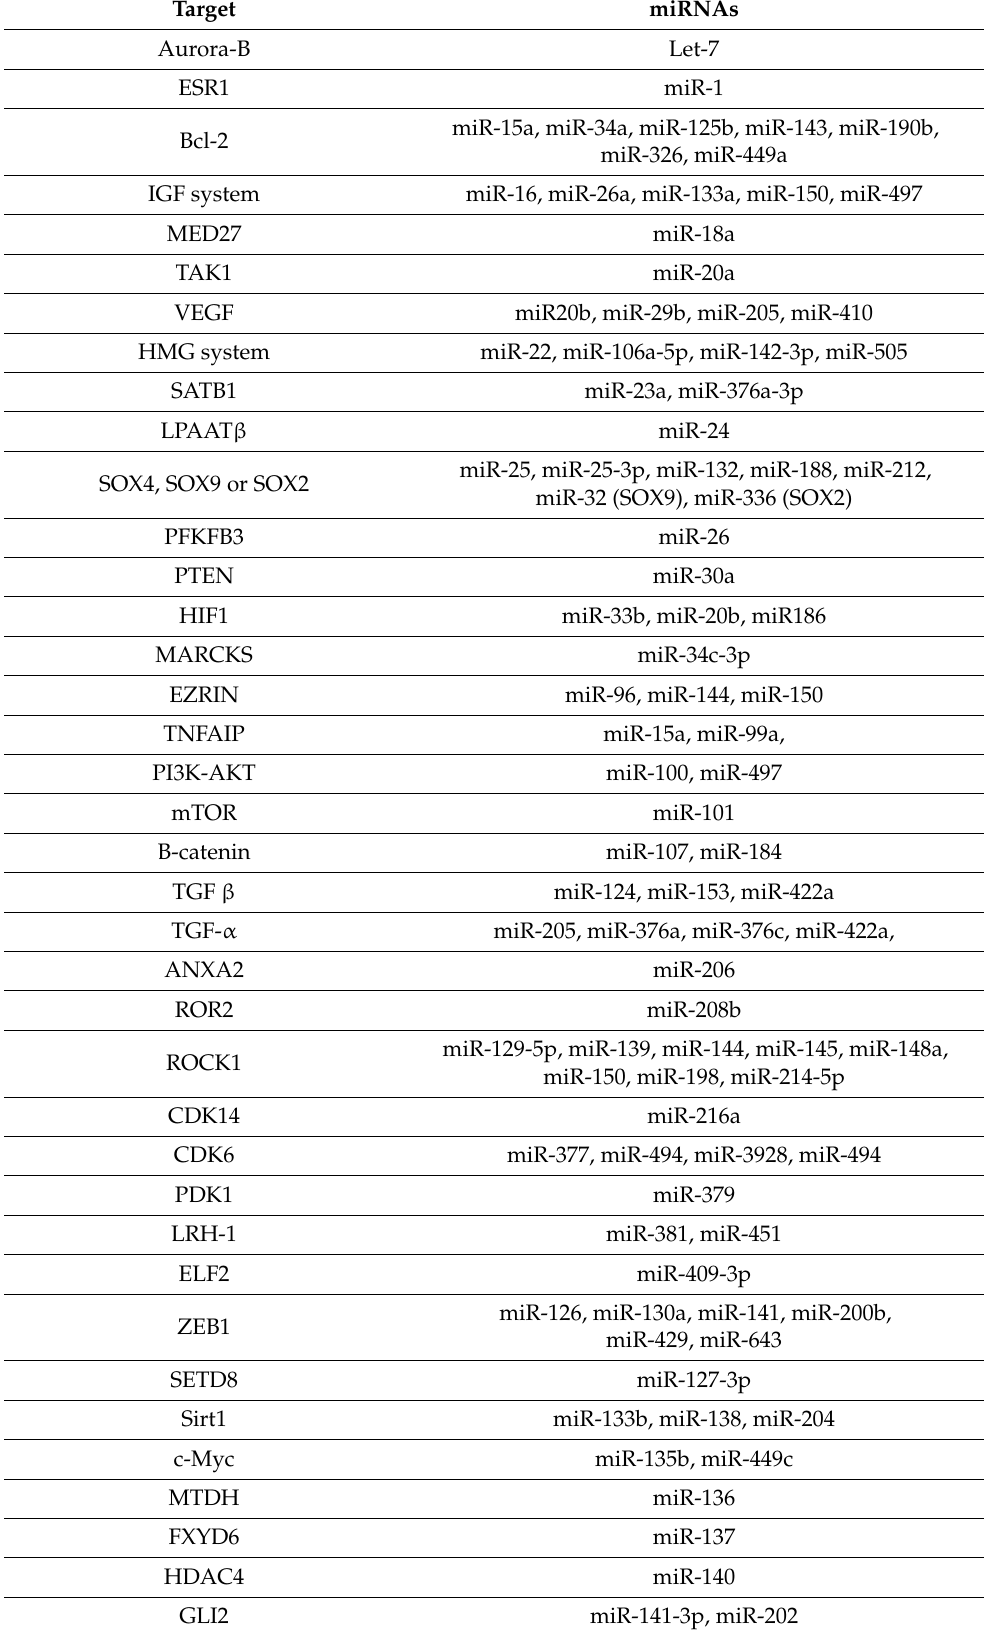
Table 1. Different tumor suppressing miRNAs downregulated and their targets in human osteosar- coma (OS) (data recovered by